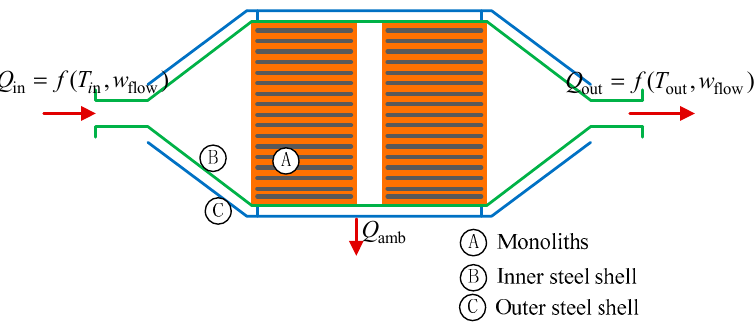
Figure 4. Schematic diagram of the three-way catalyst (TWC).